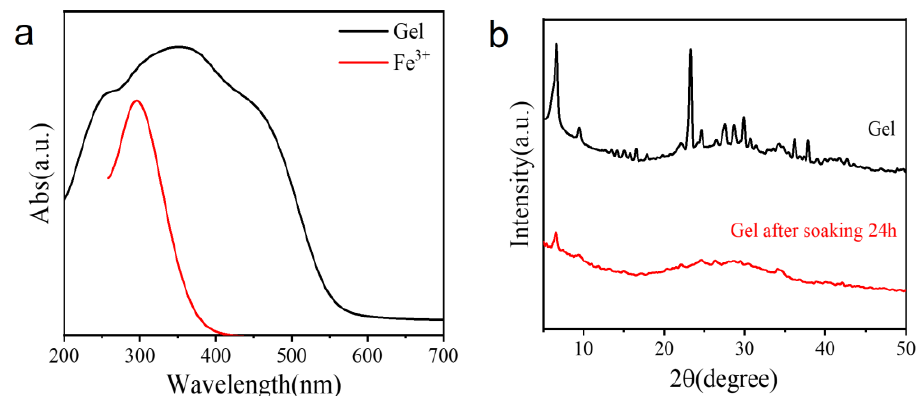
Figure 6. ( a ) UV-Vis absorption of hydrogel and Fe 3+ . ( b ) XRD of xerogel and xerogel after Fe 3+ soaking 24 h.